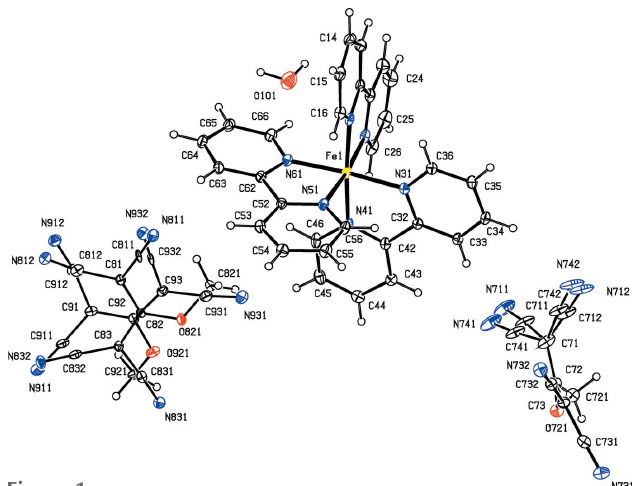
Figure 1 The independent ionic components in compound (I), showing the atom- labelling scheme. Displacement ellipsoids are drawn at the 30% probability